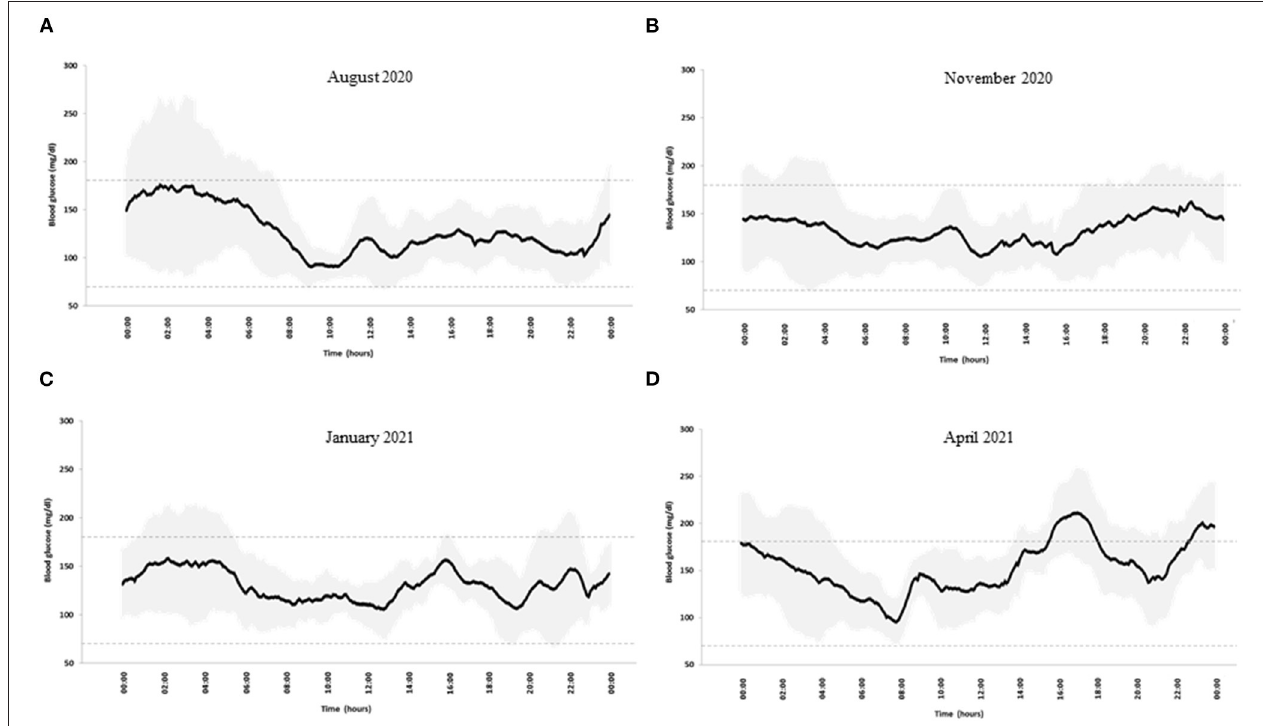
FIGURE 1 | Blood glucose profile in (A) August 2020, (B) November2020, (C) January 2021, and (D) April 2021. Black line: mean blood glucose concentrations; gray shadows: glucose variability expressed as SD. Dotted lines indicate blood glucose time in the range 70–180